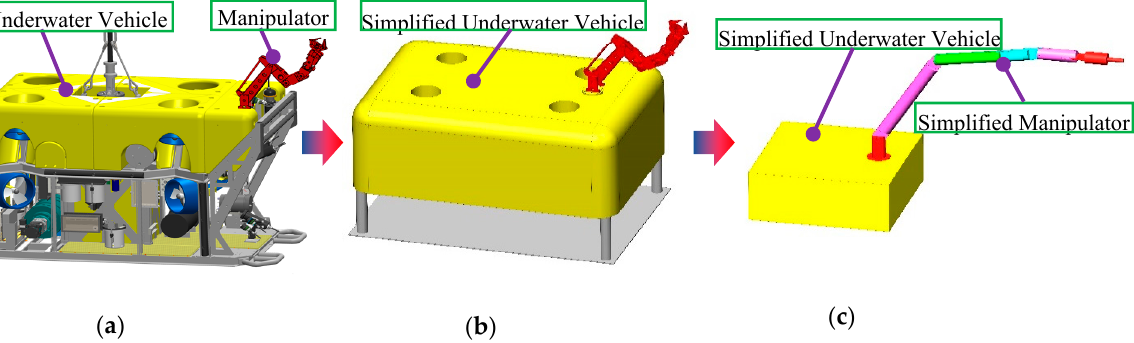
Figure 1. Mechanical Structure of UVMS. ( a ) Physical Model; ( b ) Model for Fluid Dynamics; ( c ) Model for Mechanism Dynamics.